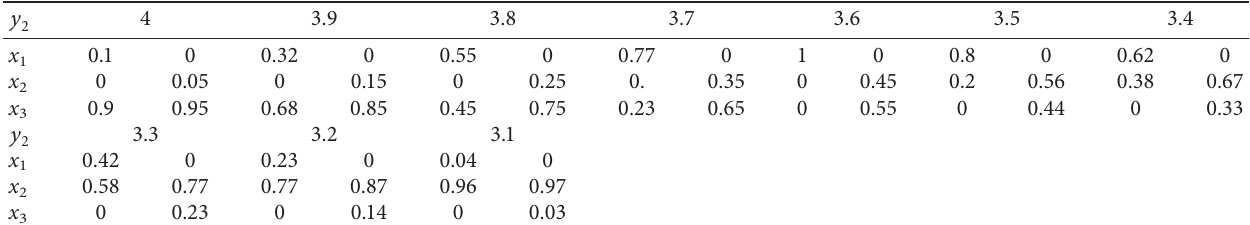
Table 12: Peak displacement y 2 regression equation